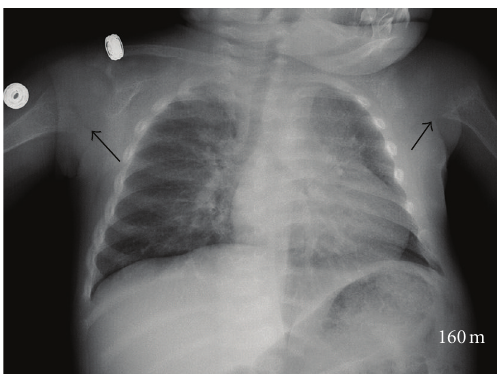
Figure 3: Chest radiograph of a 17-month-old female with pain and recent trauma. The proximal metaphyses of each humerus are irregular with widening (long